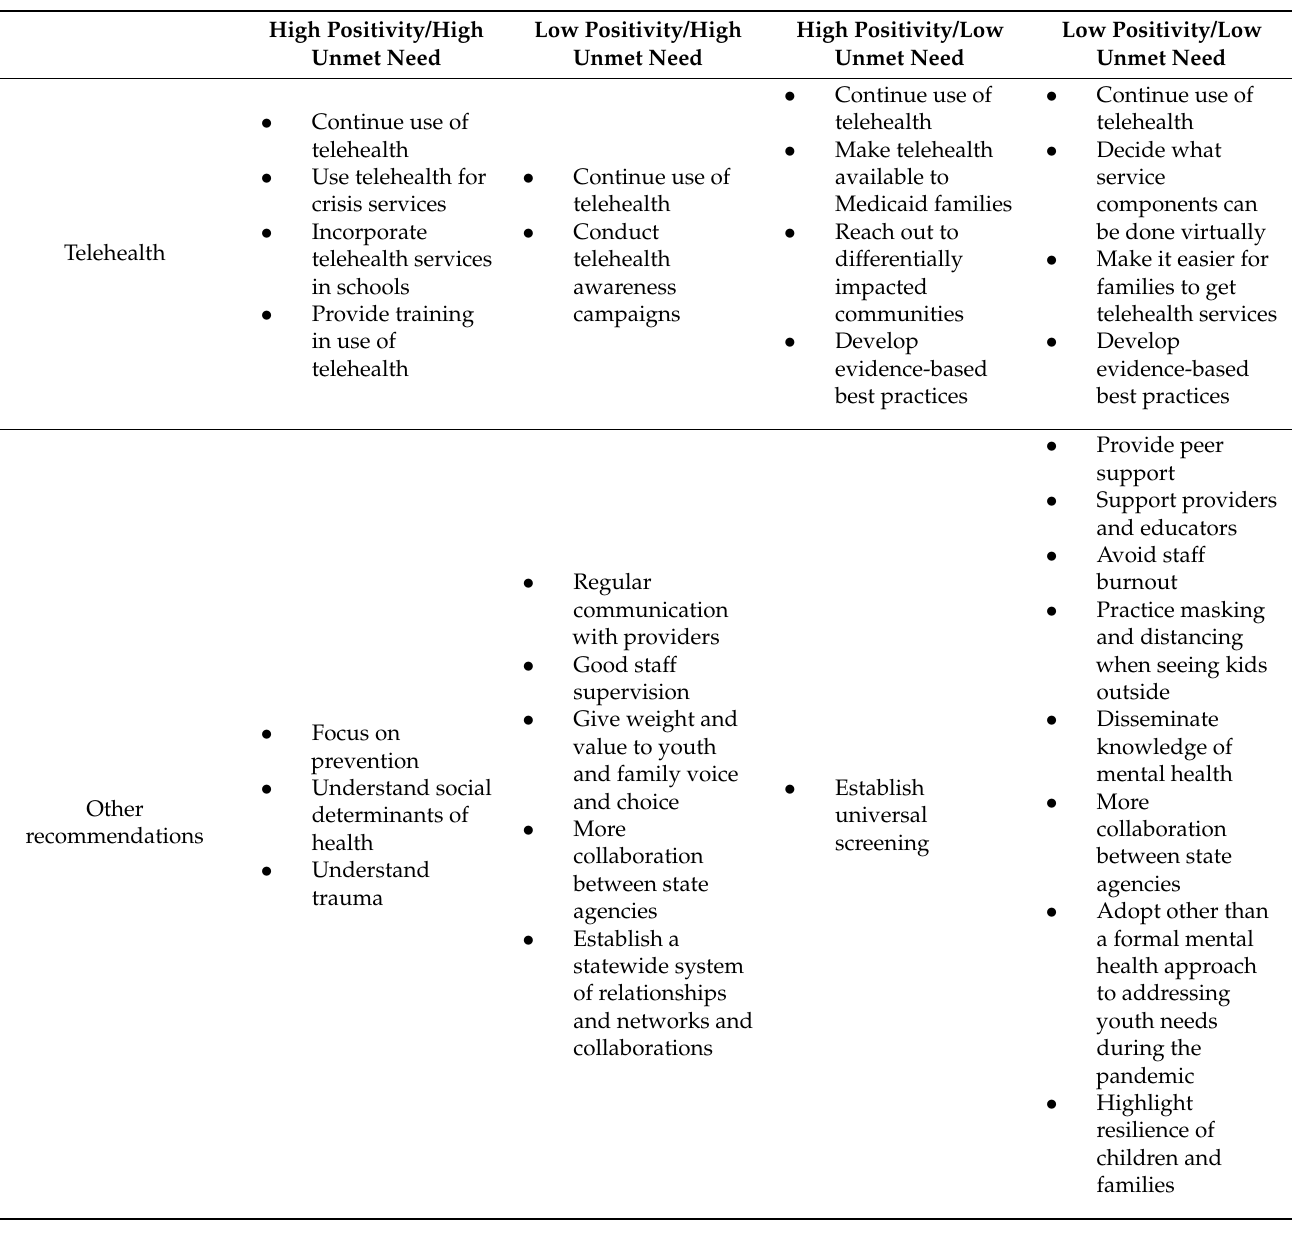
Table 6. Recommendations by levels of coronavirus positivity and unmet need for child and adolescent mental health ser-